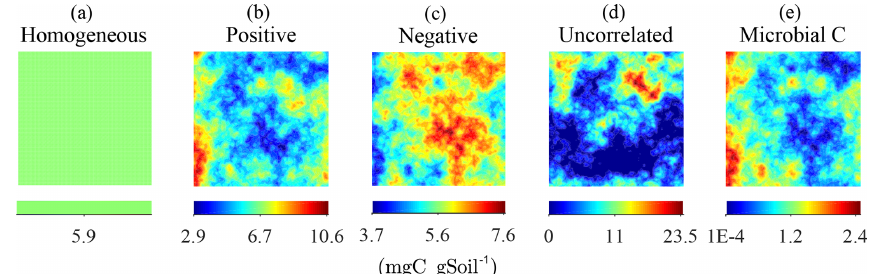
Figure 2. Steady-state simulation: examples of the homogeneous (a) and the heterogeneous distributions of substrate C constrained to have the same total amount of substrate C (b–d) . The fields in (b–d) were obtained by imposing different degrees of correlation with the initial heterogeneous distributions of microbial C, shown in (e) .